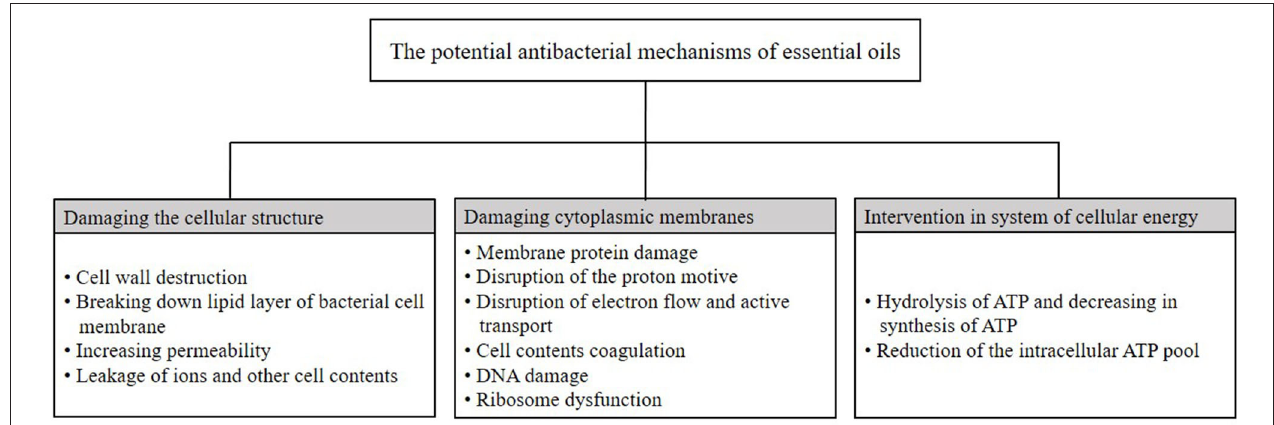
FIGURE 1 | The potential mechanisms of essential oils activity on microorganisms.